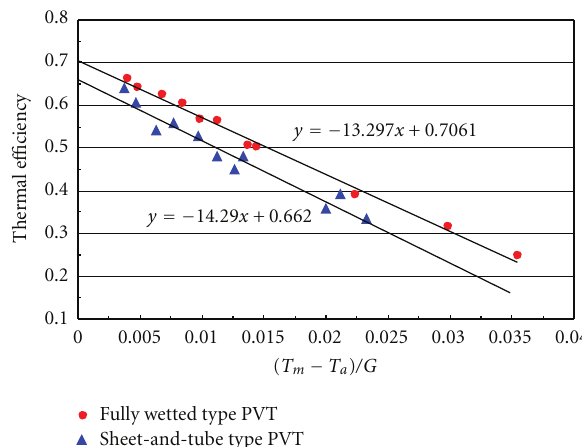
Figure 6: Electrical e ffi ciency of the fully wetted and sheet-and-tube PVT collectors.